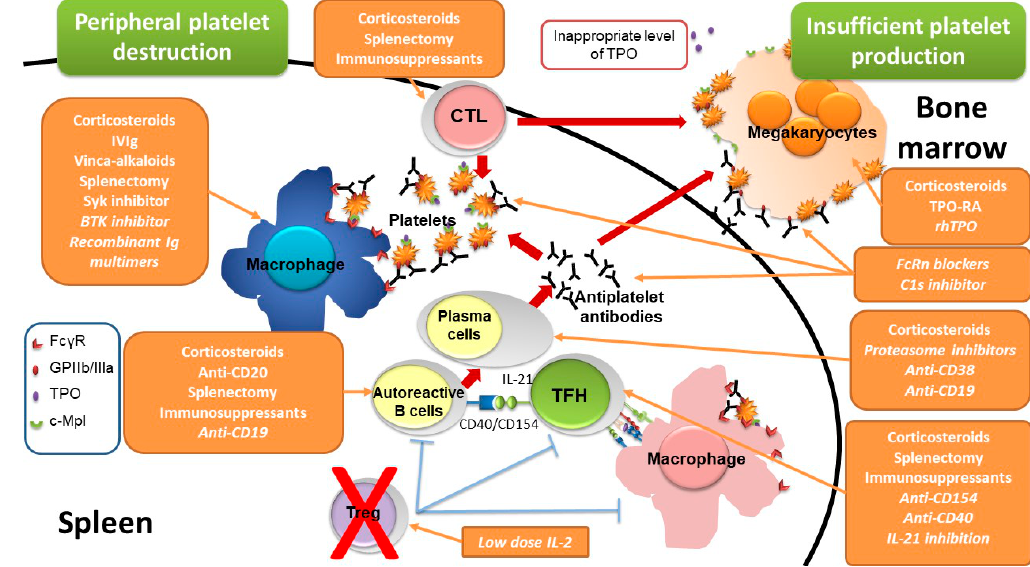
Figure 1. Pathogenesis of immune thrombocytopenia and sites of drug action. Immune thrombocytopenia results from both a peripheral destruction of platelets, mostly occurring in the spleen, and an insufficient bone marrow production. Peripheral platelet destruction is supported by antiplatelet antibodies produced by plasma cells that differentiate from B cells stimulated by T follicular helper cells through the CD40/CD154 axis and IL-21 production. Antiplatelet antibodies target platelet glycoproteins such as GPIIb/IIIa (fibrinogen receptor) leading to platelet destruction by favoring antibody-